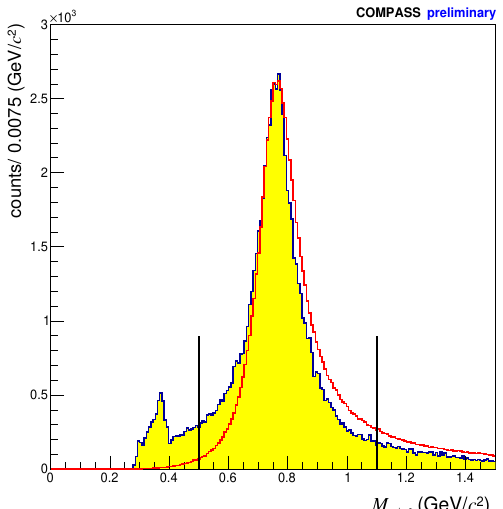
Figure 1: Distribution of the π + π − invariant mass for experimental data (blue) and for HEPGEN (red). The invariant mass from HEPGEN distribution is normalised to the data in the region 0.75 GeV / c 2 < M ππ < 0.77 GeV / c 2 , where the vertical lines indicate the applied